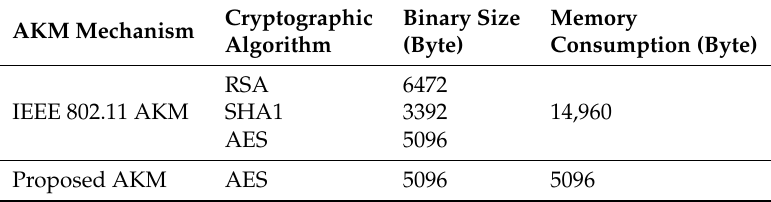
Table 7. Memory consumption of STA due to cryptographic